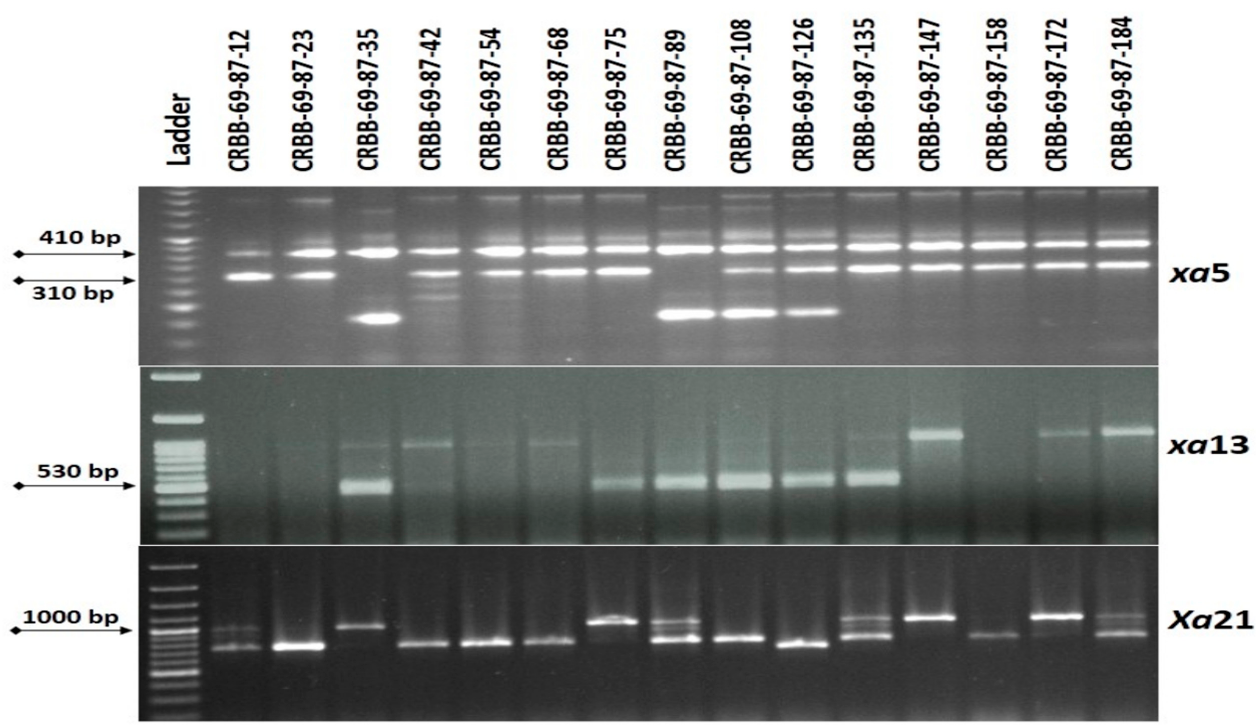
Figure 4. Representative electropherogram generated from the tracking of Xa21 , xa13 and xa5 BB resistance genes in B 3 F 1 progenies of resistance gene pyramiding of Ranidhan.